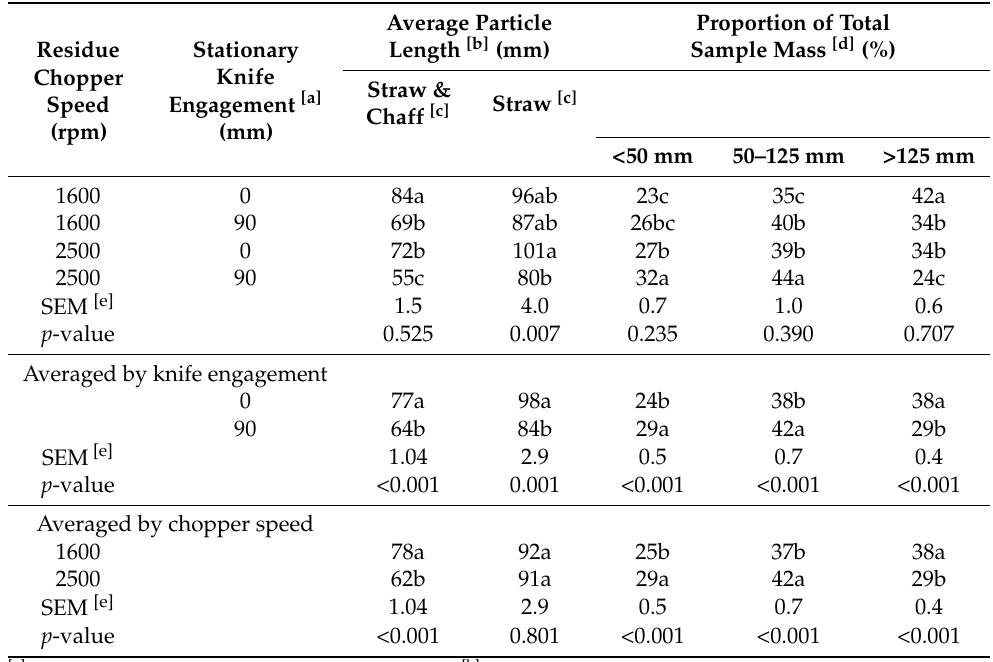
Table 3. Summary of particle-size distribution and length from Experiment 1 using various combine residue chopper configurations.